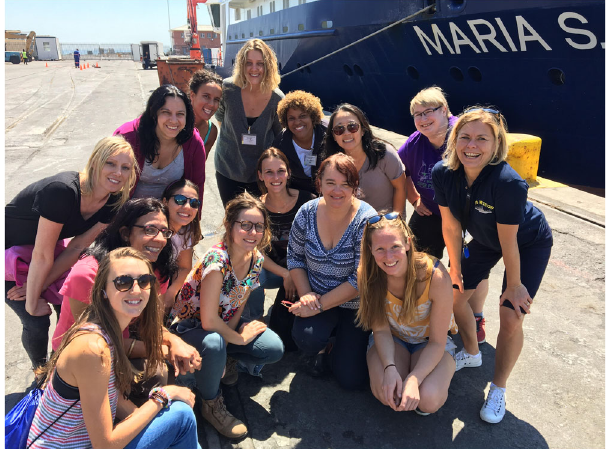
Fig. 2 South Atlantic research cruise in January 2017. A subset of the participants in the trans-basin cruise from Cape Town, South Africa to Montevideo, Uruguay aboard the German R/V Maria S. Merian in January